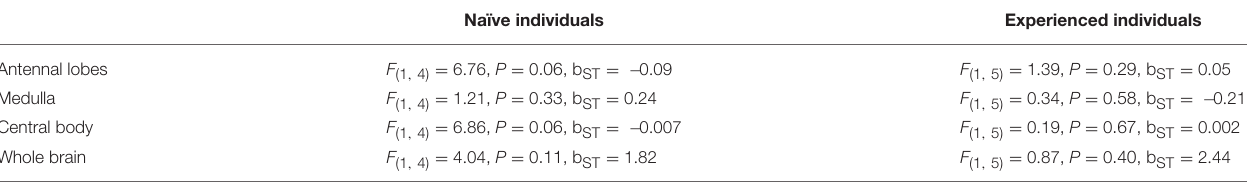
TABLE 4 | Associations between neural investment and forewing circularity. Naïve individuals Experienced individuals Antennal